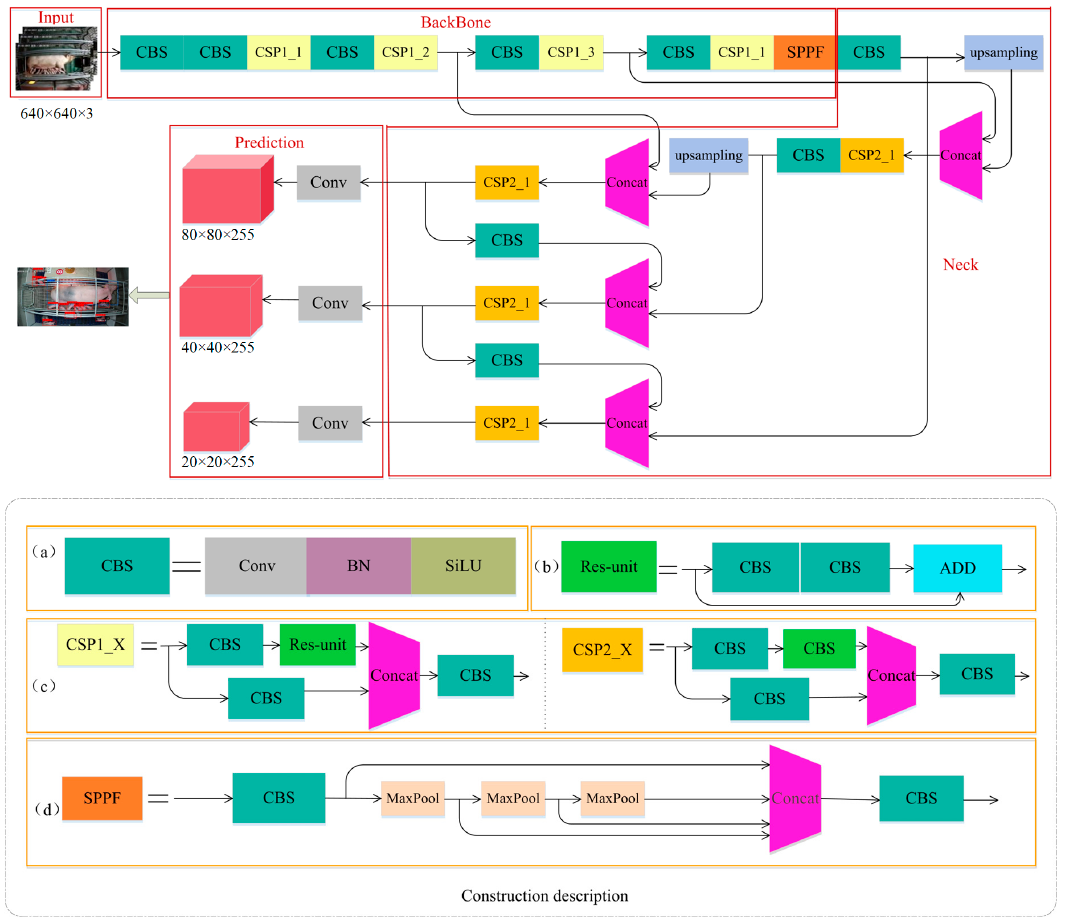
Figure 2. Network structure of the YOLOv5s algorithm ( a ) CBS module details, ( b ) Res-unit module details, ( c ) CSP1_X and CSP2_X module detail structure, and ( d ) SPPF module detail structure.